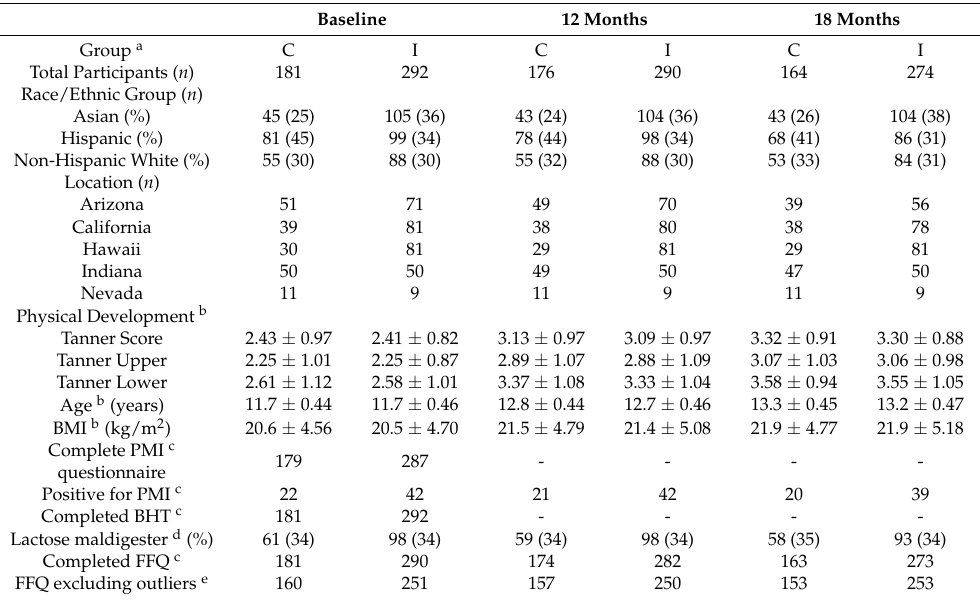
Table 1. Demographic and physiological variables among early adolescent girls by treatment group at baseline and